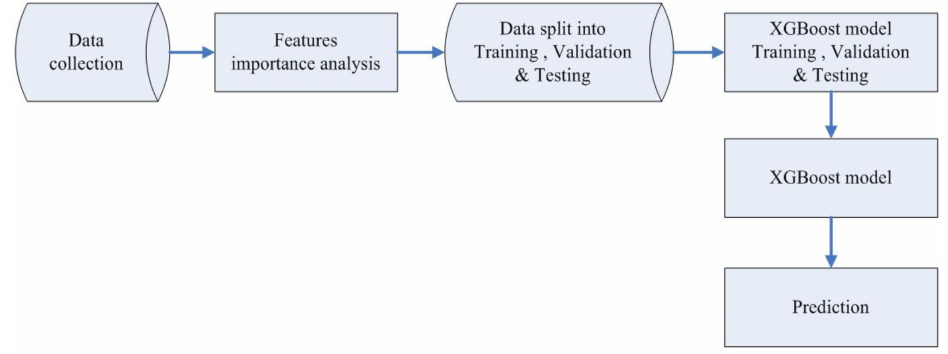
Figure 3. Flowchart of the proposed method for composition gas prediction in gasification.